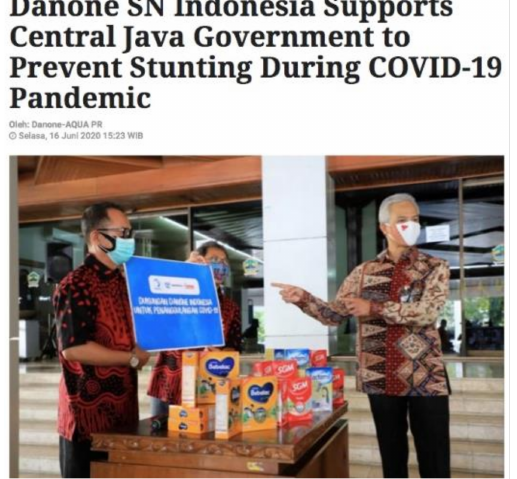
Figure 5. A screenshot of a news article about Danone’s donation of formula products (including Bebelac and SGM) to Central Java government in